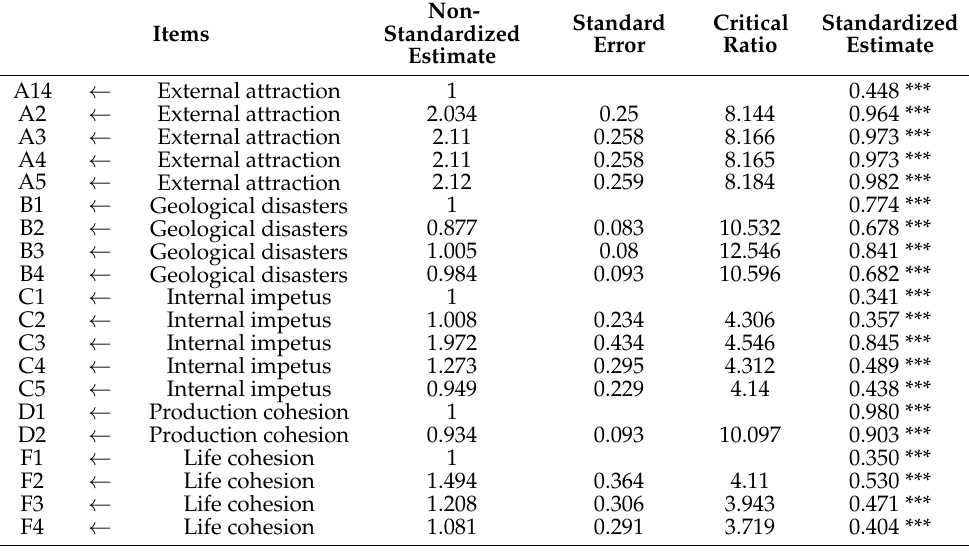
Table 6. The regression coefficient of